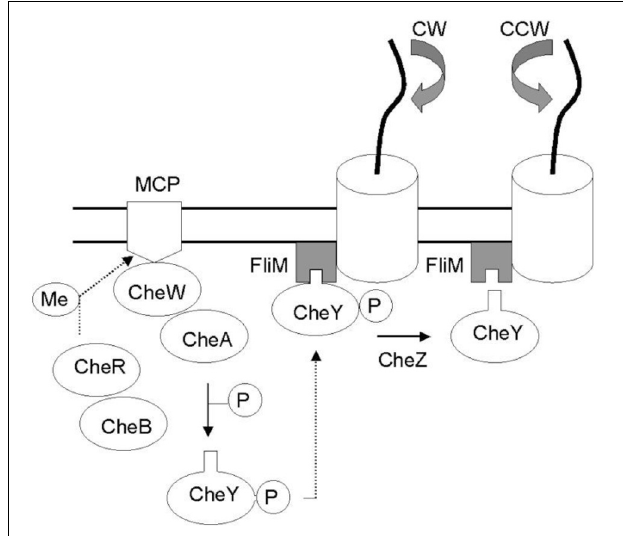
FIGURE 1 | Che protein network mediating bacterial taxis. External factors are identified by membrane receptors (MCP) which reactivity depends on methylation levels controlled by CheB and CheR cytoplasmic proteins. In the network CheW is the bridge between the receptors and protein kinase CheA which can donates a phosphate group to CheY. The binding of CheY–P to the switch complex protein FliM induces a clockwise flagellar rotation (CW) whereas the dephosphorylation of CheY (via CheZ) restores counter-clockwise flagellar rotation (CCW) (Di Paola et al.,